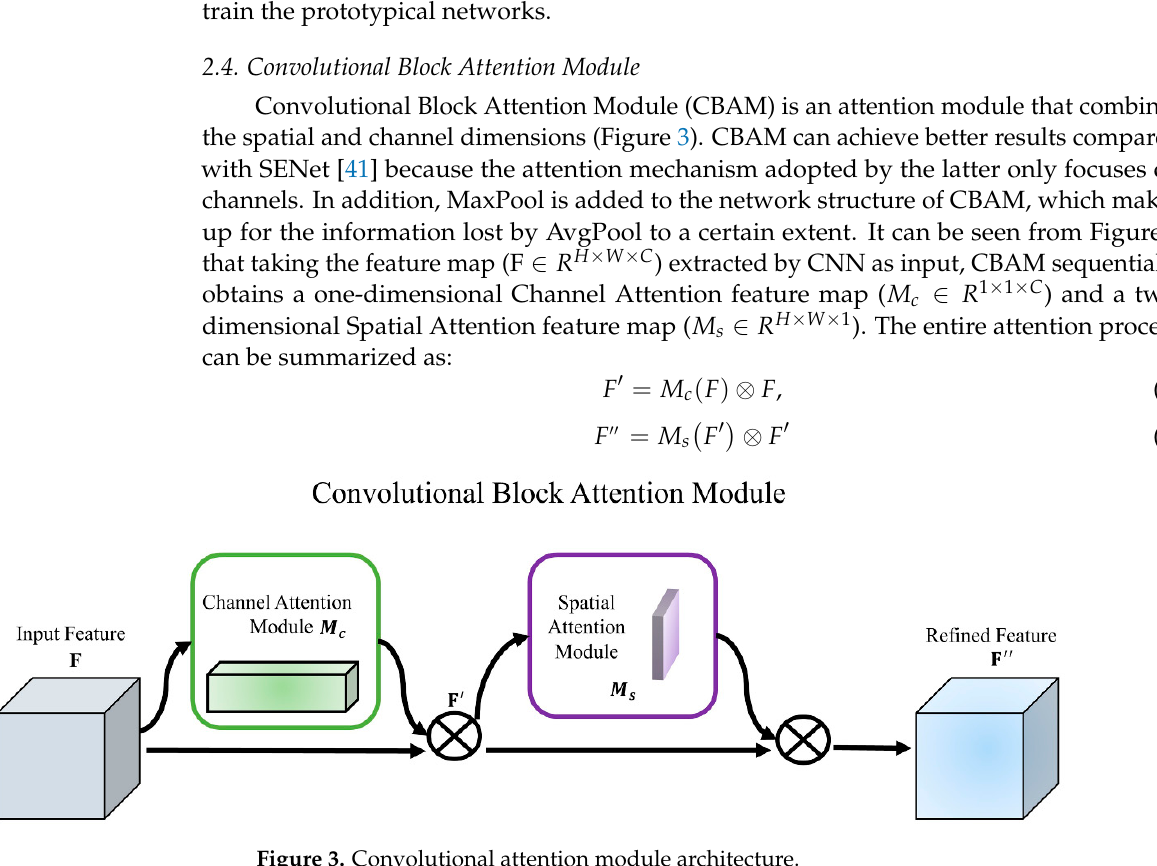
Figure 3. Convolutional attention module architecture.